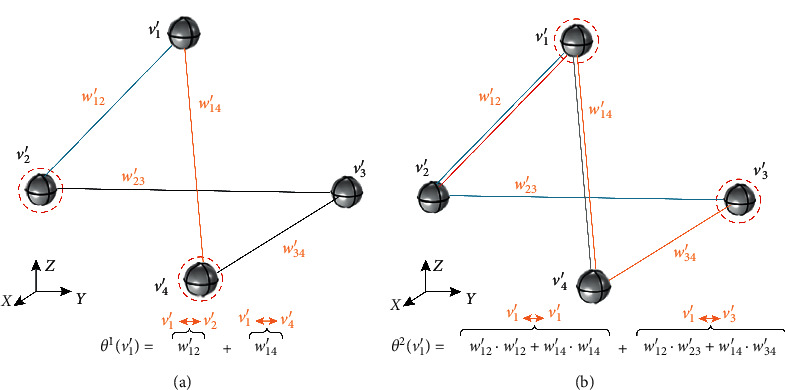
The weighted influence of node v1′ in G′: (a) 1-hop path; (b) 2-hop path.